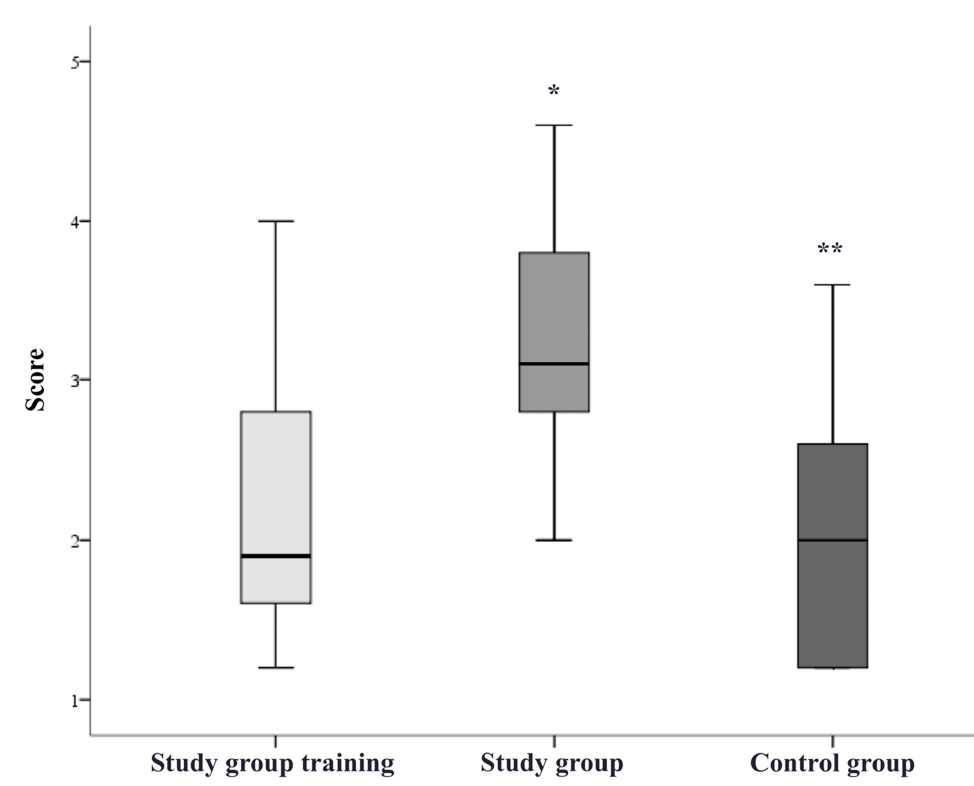
Figure 5. Overall grading results. Legend: score range 1–5, * p < 0.05 compared to study group training, ** p < 0.05 compared to study group.